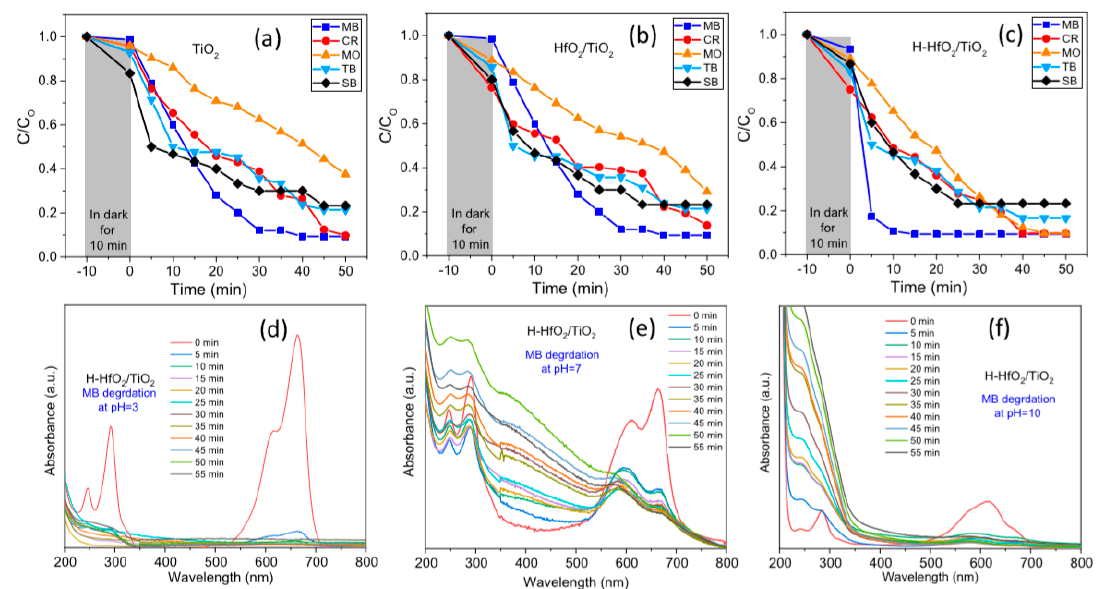
Figure 8. ( a – c ) Degradation of 5 diverse dyes (solo-chrome black (SB), thymol blue (TB), cresol red (CR), methyl blue (MB), and methyl orange (MO)) utilizing titanium dioxide (TiO 2 ), hafnium oxide (HfO 2 ) / TiO 2 , and hydrogenated HfO 2 doped TiO 2 (H-HfO 2 / TiO 2 ) at pH 7. ( d – f ) The degradation of MB dye at various pH employing the H-HfO 2 / TiO 2 . Reproduced from reference [120], with permission from Elsevier, 2018.